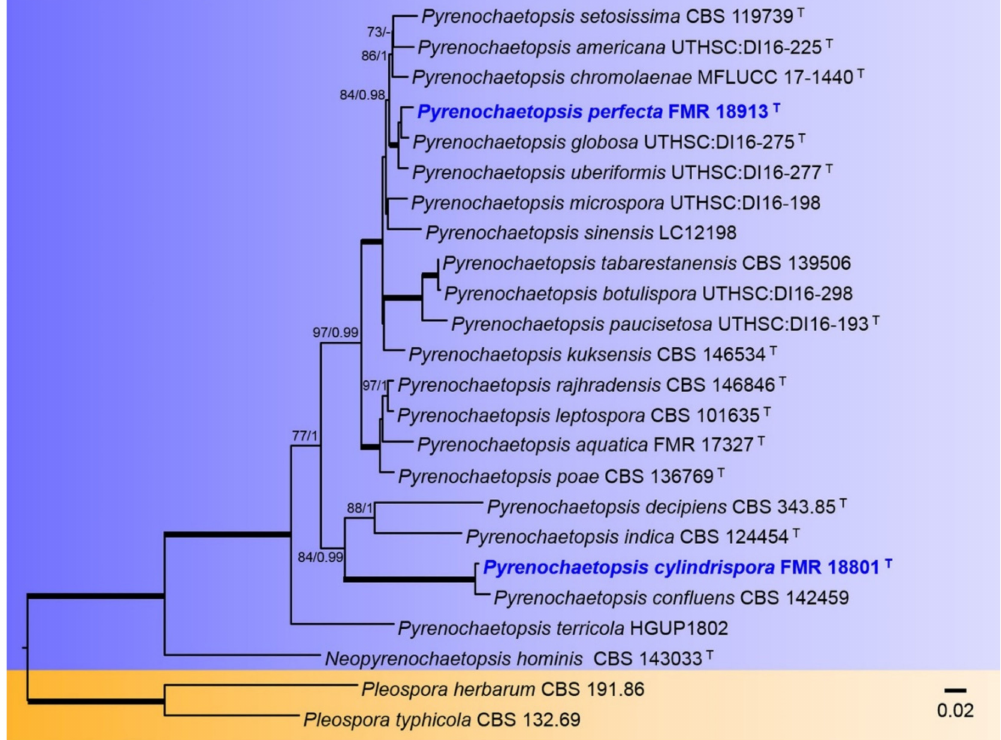
Figure 8. Phylogenetic tree inferred from an ML analysis based on a concatenated alignment of ITS, rpb2, and tub2 sequences of 24 strains representing species in the Pyrenochaetopsidaceae . The RAxML bootstrap support values (BS) above 70% and the Bayesian posterior probabilities (PP) above 0.95 are given at the nodes (BS/PP). Fully supported branches (100 BS/1 PP) are indicated in thicker lines. Newly proposed taxa are given in blue . Type strains are indicated by a superscript “T”. The tree was rooted with Pleospora herbarum CBS 191.86 and P. typhicola CBS 132.69. Alignment length 1488